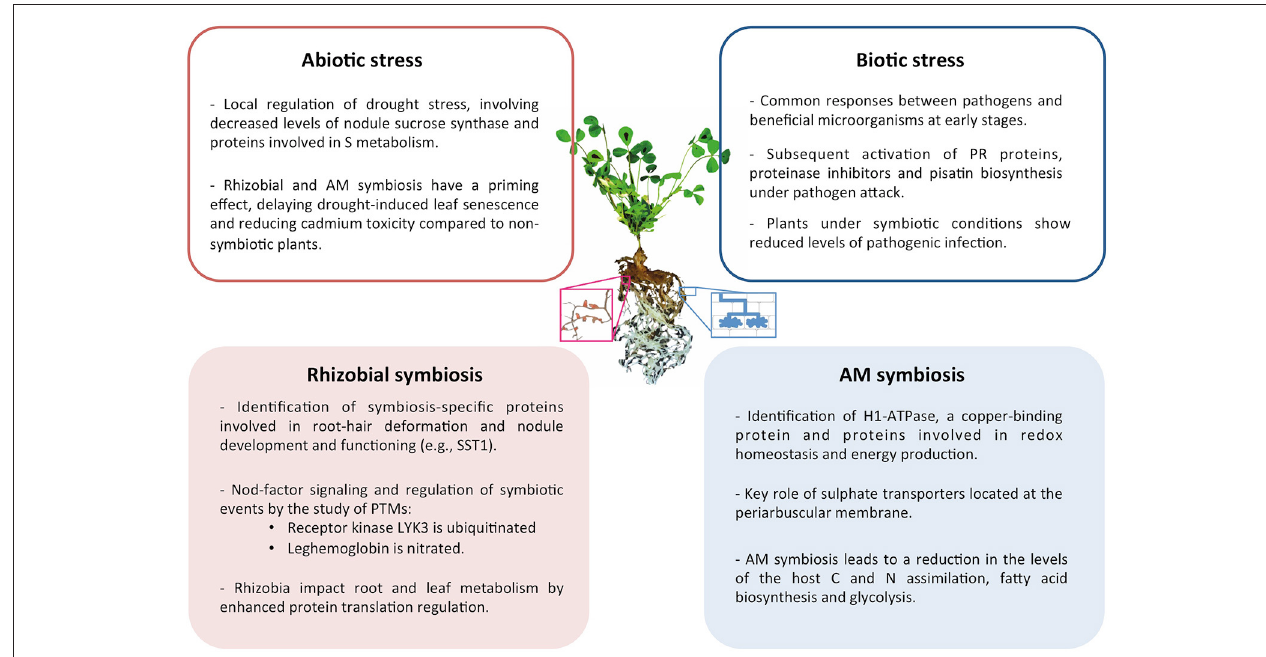
FIGURE 1 | Summary of the main conclusions drawn from proteomic studies of symbiotic legume plants and their interactions under abiotic and biotic stress conditions. Center image represents a M. truncatula plant and a magnified image of nodulated roots (left) and schematic representation of cells containing AM fungi